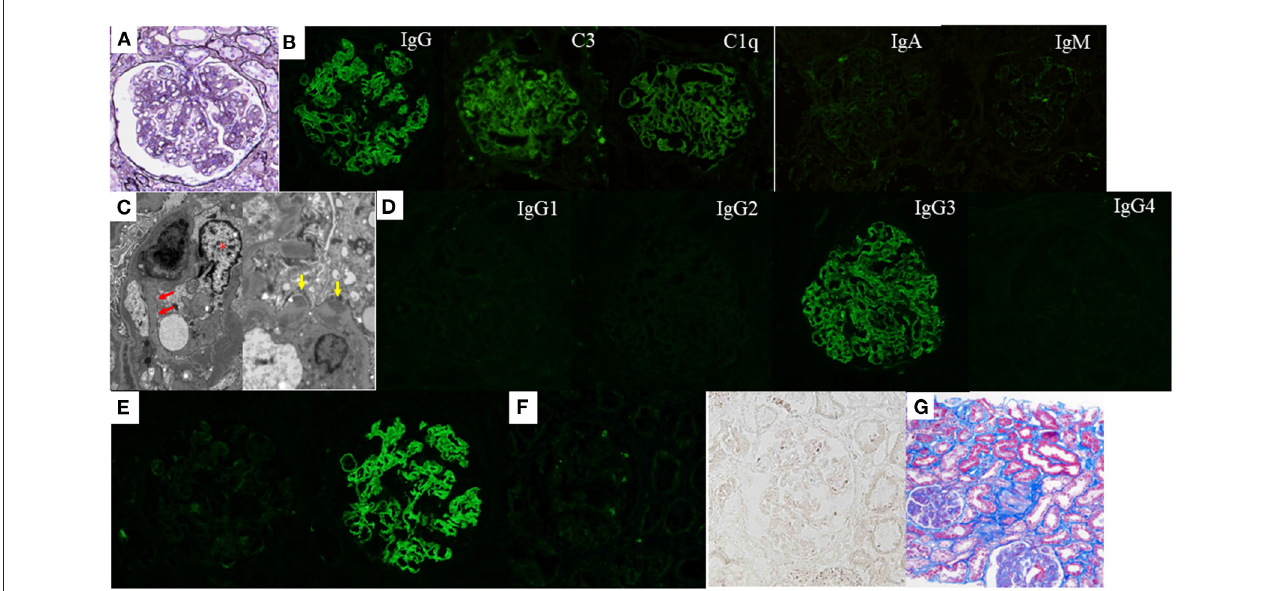
FIGURE1 Histological features of the renal biopsy of case 1. (A) Light microscopy section shows a glomerulus with mesangial expansion and endocapillary proliferation as well as thickening and double contour of capillary walls (periodic acid-methenamine-silver stain). (B) Strong deposition of immunoglobulin (Ig) G, complement C3, and C1q are observed along the glomerular capillary walls by immunofluorescence (IF) staining. The deposition of IgA and IgM was ambiguous. (C) Subendothelial and mesangial electron-dense deposits are shown by electron microscopy. Newly formed glomerular basement membrane (red arrows) and infiltration of macrophages (asterisk) are also observed (left). Small amounts of subepithelial electron-dense deposits (yellow arrows) were also observed (right). (D) IF staining for IgG subclasses demonstrates sole deposition of IgG3. (E) There is no deposition of kappa-light chain by IF staining (left), whereas strong deposition of lambda-light chain is observed (right). (F) Both IF staining for nephritis-associated plasmin receptor (left) and in situ zymography for plasmin activity (right) are positively observed with a similar distribution in a glomerulus. (G) The degree of interstitial fibrosis and tubular atrophy are mild (Masson’s trichrome